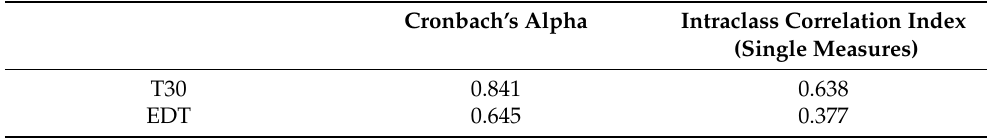
Table 5. Reliability statistics and interclass correlation for T30 and